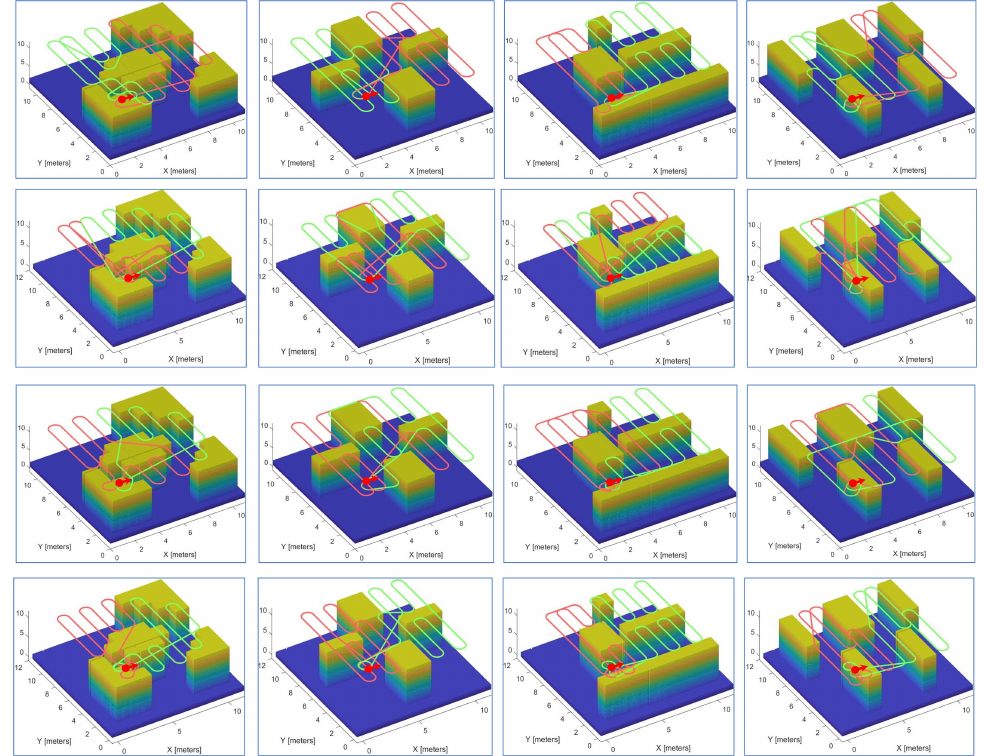
Figure 10. Simulation instances with two robots. The first to fourth rows represent the snapshots of the coverage paths provided by Milpflow [20], DCRC [3], EDM, and CDM, respectively.